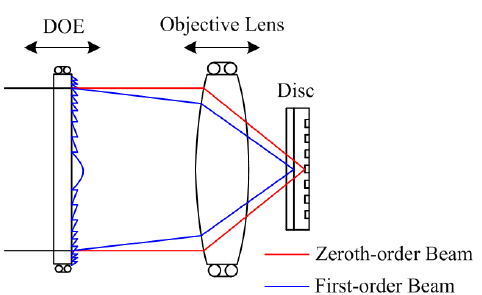
Figure 3. Beam separation by the